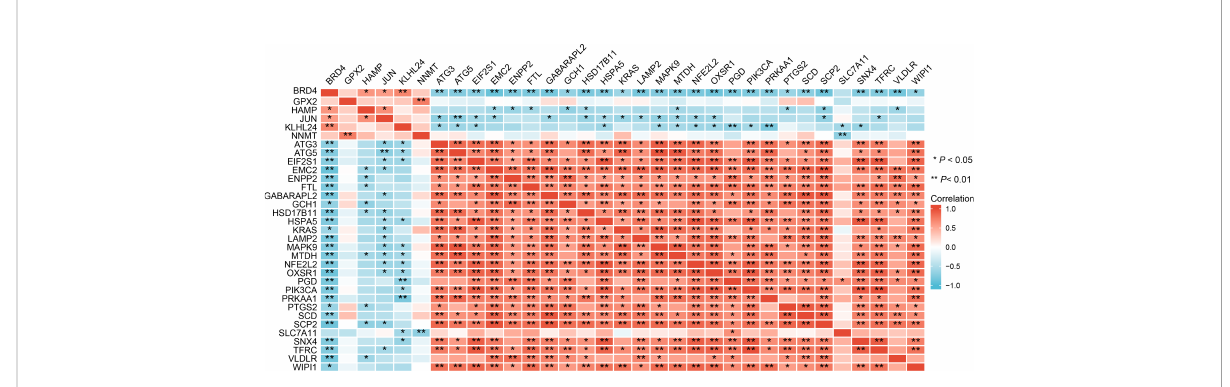
FIGURE 7 Spearman correlation analysis of the 33 ferroptosis-related DE-mRNAs.